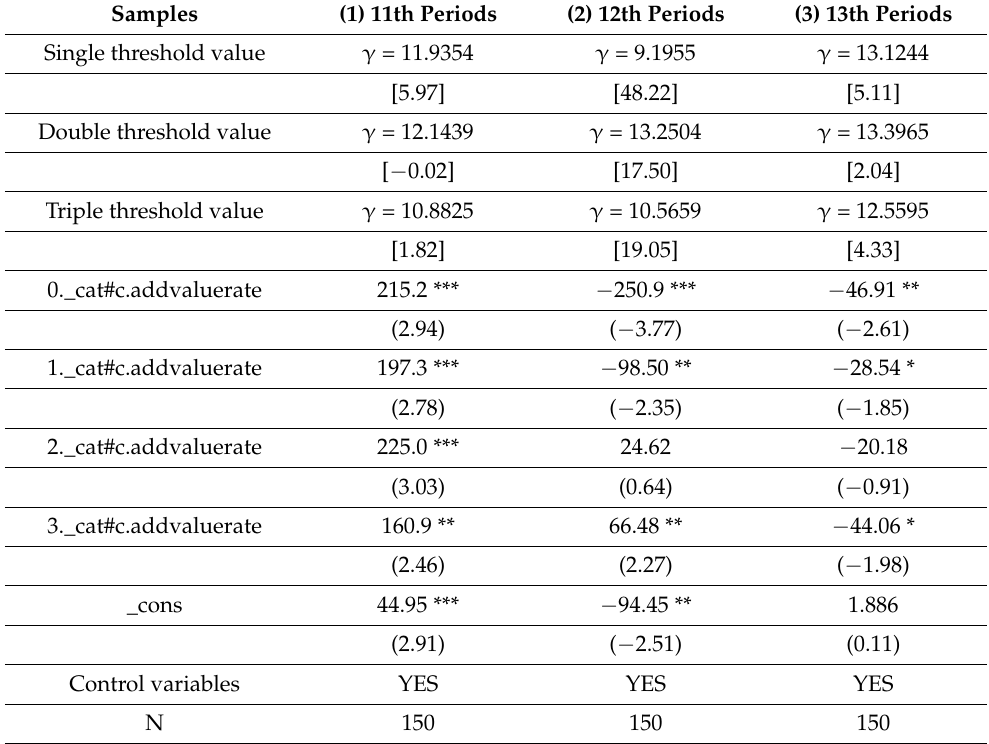
Table 7. Regression results of threshold effects in different